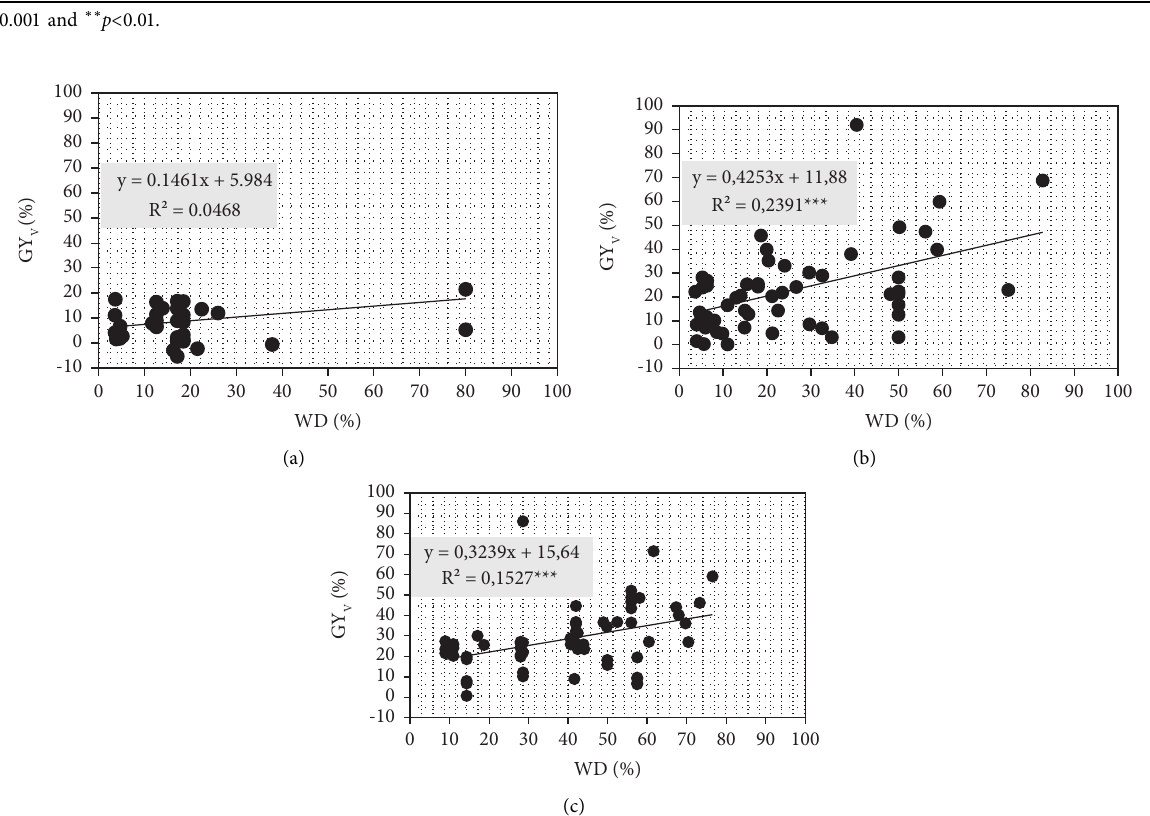
Figure 6: Trend of maize yield loss under defcit irrigation set at (a) vegetative stage, (b) reproductive stage, and (c) at both vegetative and reproductive stages; ∗∗∗ p < 0.001.